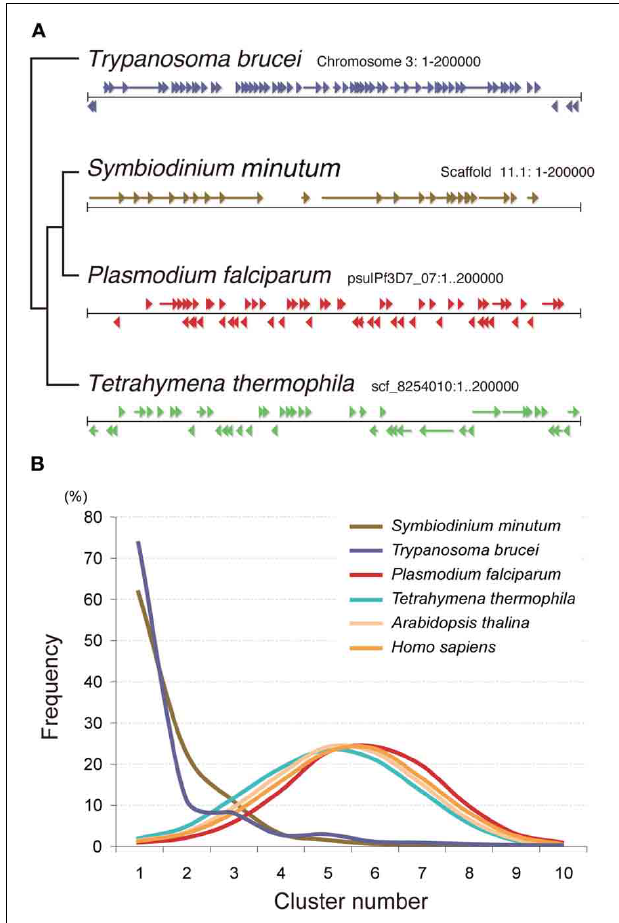
FIGURE 11 | Nuclear gene arrangement in the Symbiodinium minutum genome. (A) Examples of gene arrangement in the 200-kbp nuclear genome are shown and compared among Symbiodinium minutum (dinoflagellate), Trypanosoma brucei (euglenozoan), Plasmodium falciparum (apicomplexa), and Tetrahymena thermophila (ciliate). In contrast to the genomes of Tetrahymena , Plasmodium , and Acropora, that show a random arrangement of protein-coding genes (arrowheads and arrows), the genomes of S. minutum and Trypanosoma are arranged into a large directional gene cluster in a head-to-tail orientation. (B) A search of the directional gene cluster using a 10-gene window shows the strong tendency toward unidirectional alignment of genes in the S. minutum and Trypanosoma genomes. Each line represents a frequency histogram for changes in the gene orientation between successive genes in the genome. The X-axis represents the number of orientation changes as one moves through windows of 10 genes. For examples as indicating random orientation, the poisson distributions with μ = 4 . 5 (average) and 0.2 are